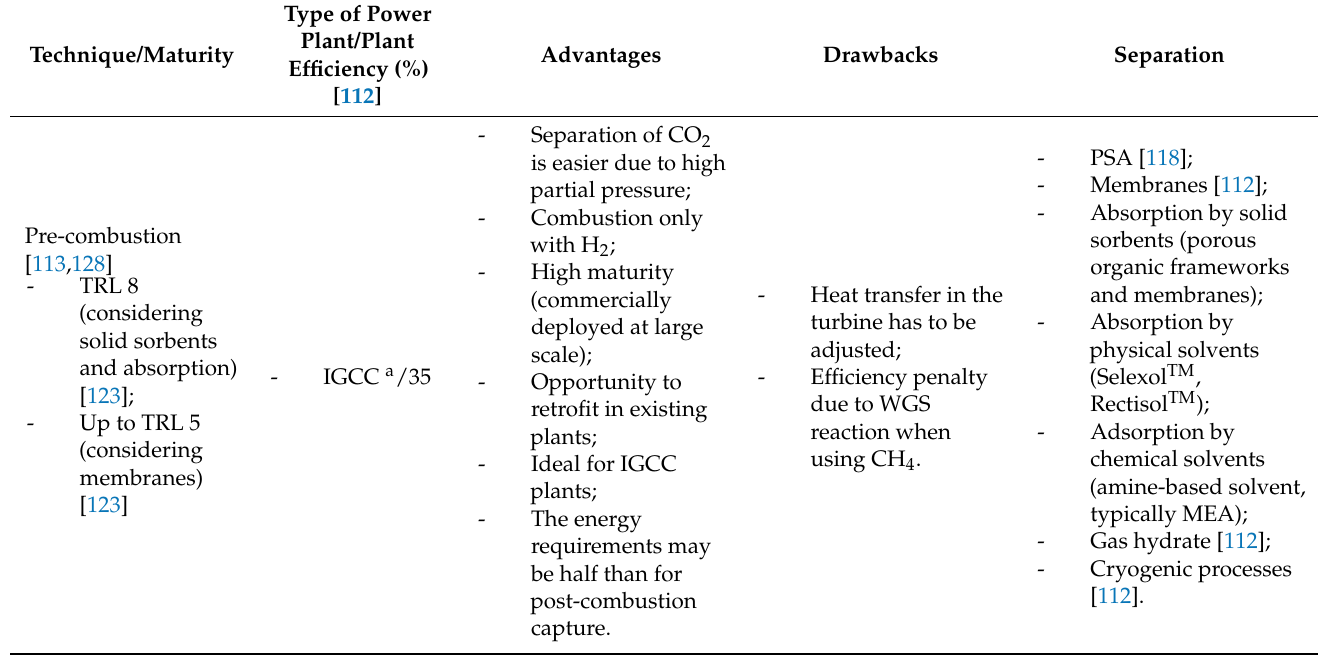
Table 9. Fundamental characteristics of carbon capture